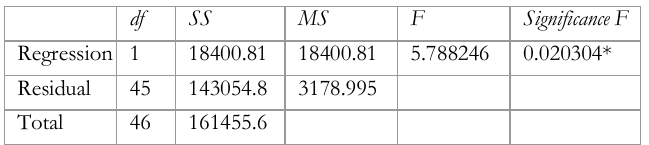
Table 2. One-way ANOVA results